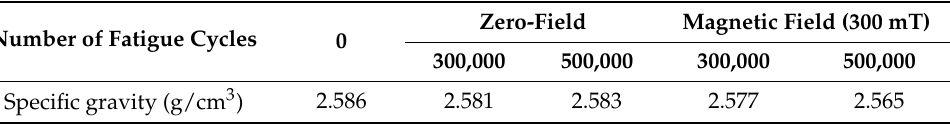
presence of a magnetic field.